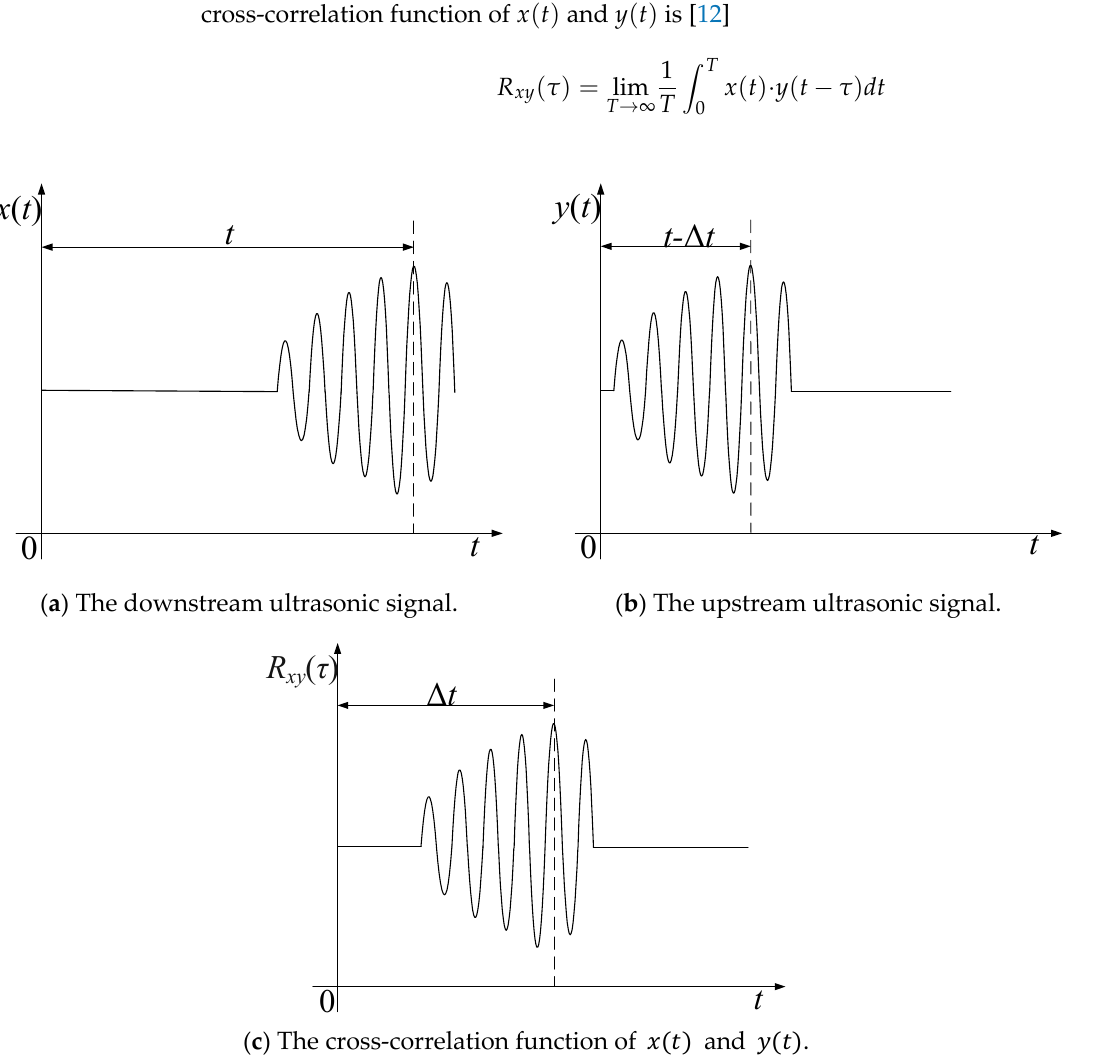
Figure 1. The principle of the cross-correlation method.